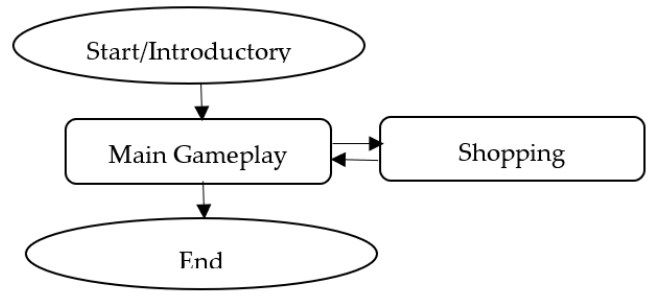
Figure 8. Switching among different parts.